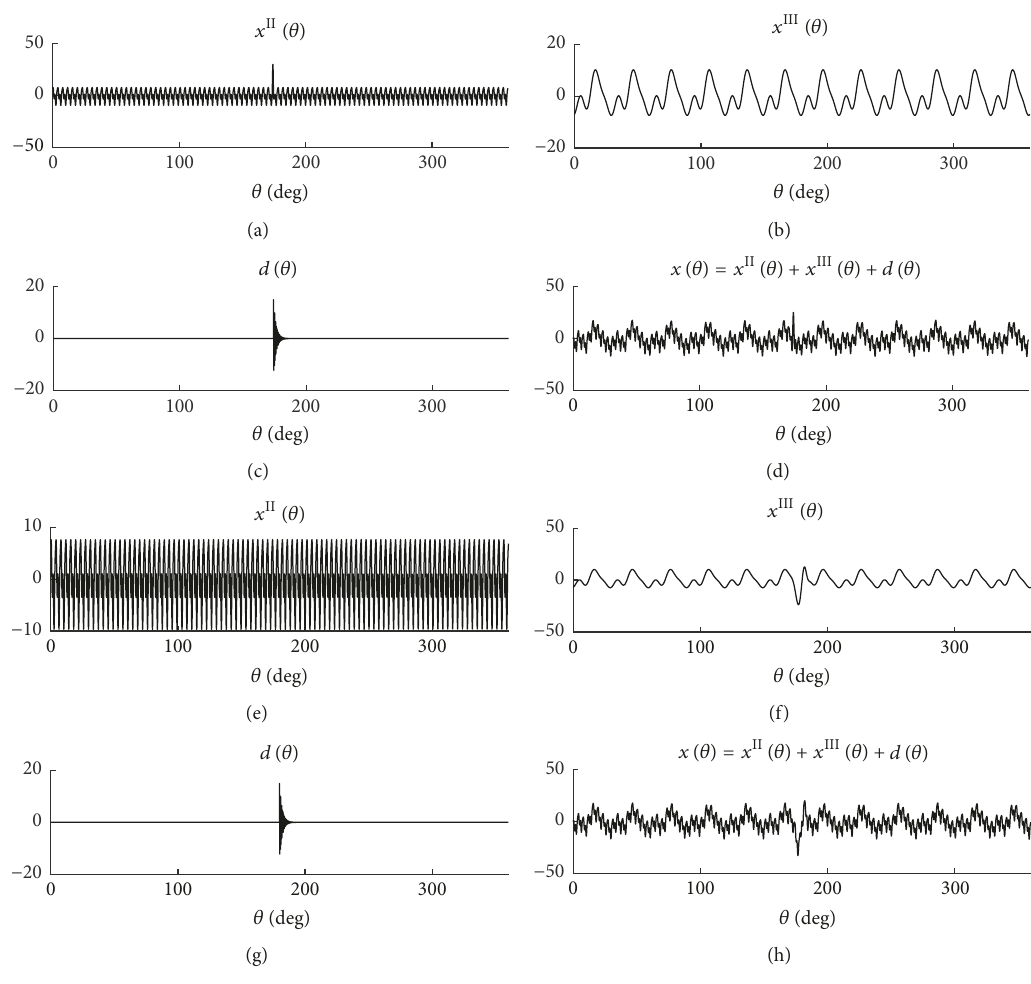
Figure 6: Simulated signals in the angle domain: (d) 𝑥 sim , II and (a–c) its components and (h) 𝑥 sim , III and (e–g) its components.